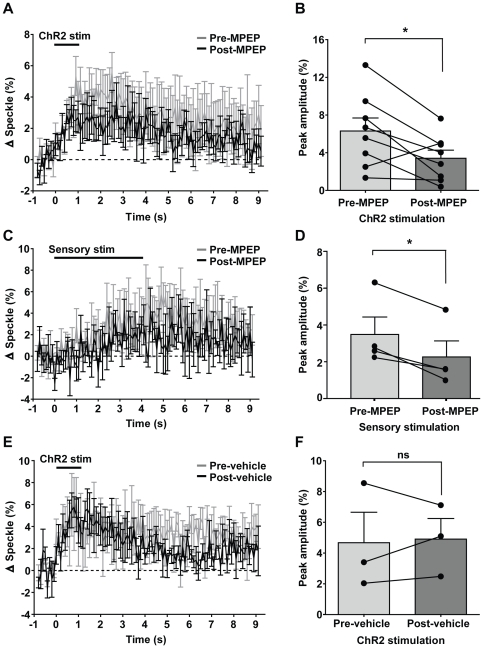
ChR2-evoked and sensory-evoked changes in blood flow are partially reduced by the mGluR5 antagonist MPEP.A, Temporal profiles of laser speckle responses evoked by 1 s of ChR2 stimulation before and after antagonist incubation. B, Comparison of peak amplitudes (averaged over 1 s) in laser speckle contrast responses in (A) before and after antagonist incubation. A significant difference was observed (n = 8, paired t-test, p = 0.0251). C, Temporal profiles of laser speckle responses evoked by sensory stimulation before and after antagonist incubation. D, Comparison of peak amplitudes (averaged over 1 s) in laser speckle contrast responses in (C) before and after antagonist incubation. A significant difference was observed (n = 4, paired t-test, p = 0.0155). E, Temporal profiles of laser speckle responses evoked by ChR2 stimulation before and after injection of saline vehicle. F, Comparison of peak amplitudes (averaged over 1 s) in laser speckle contrast responses in (E) before and after saline injection. No significant difference was observed (n = 3, paired t-test, p = 0.8211). Error bars represent SEM.